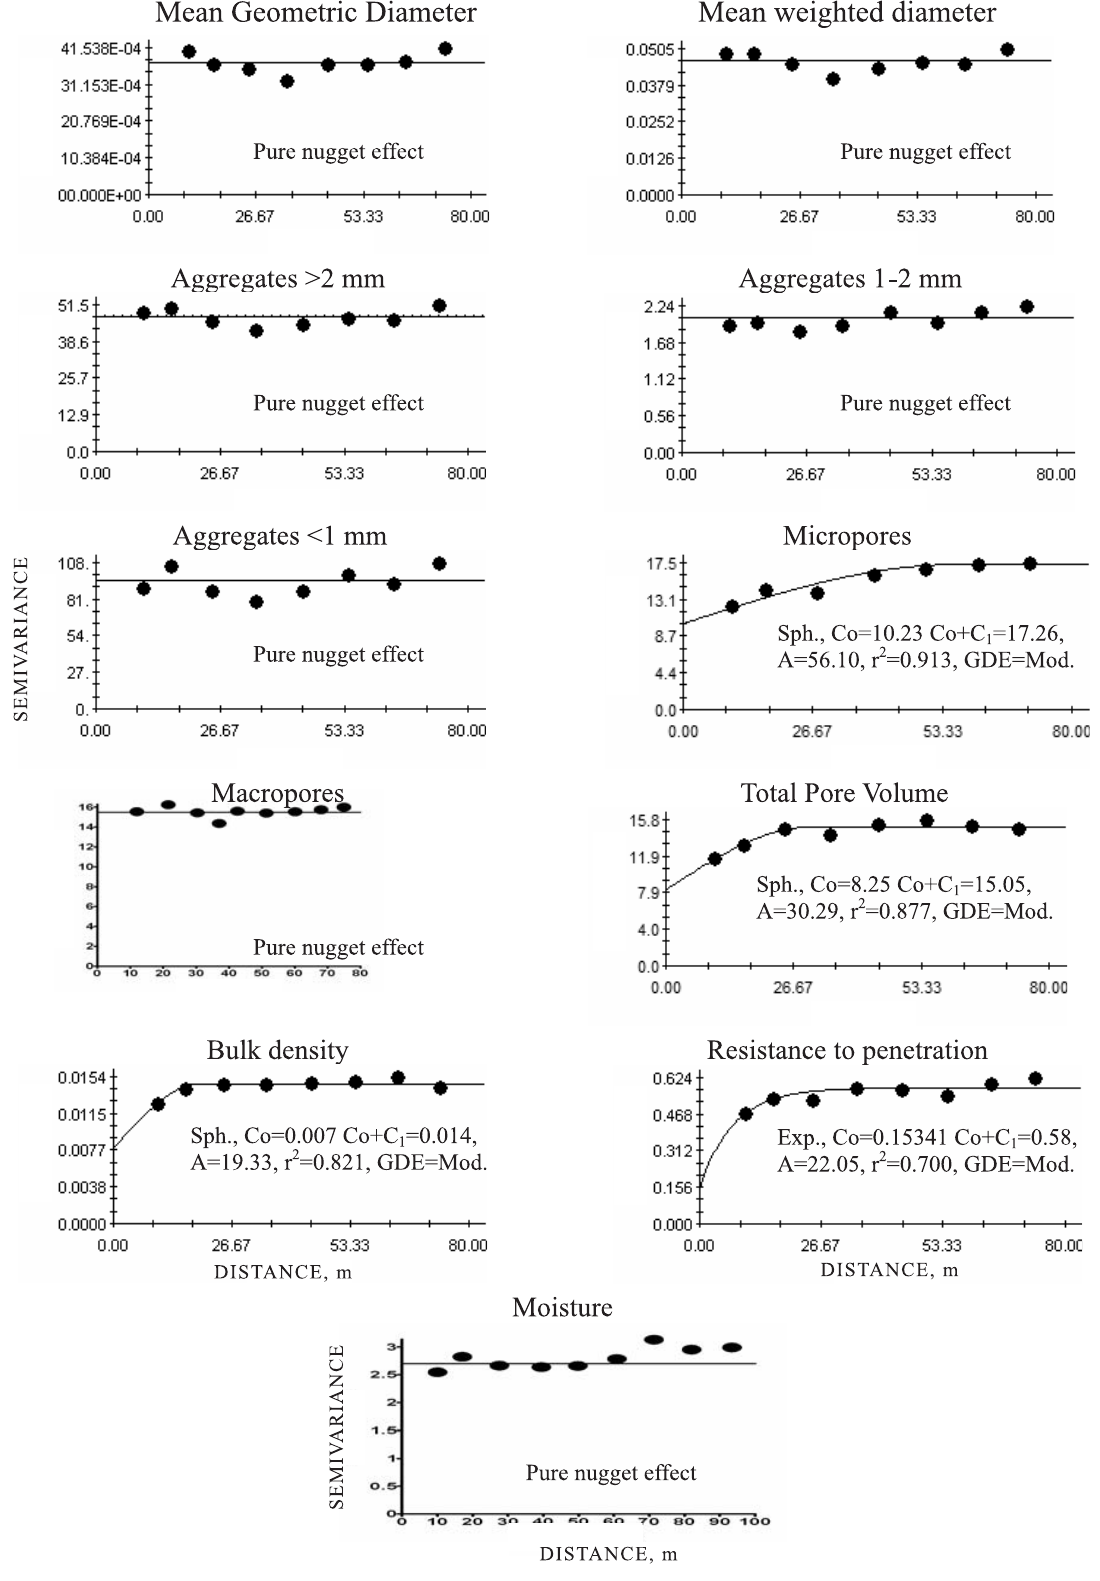
Figure 4. Semivariograms of the studied attributes of the concave area (0–0.2 m). Exp.: exponential; Sph.: spherical; Co: nugget effect; C : sill; a: range (m); r 2: coefficient of 1